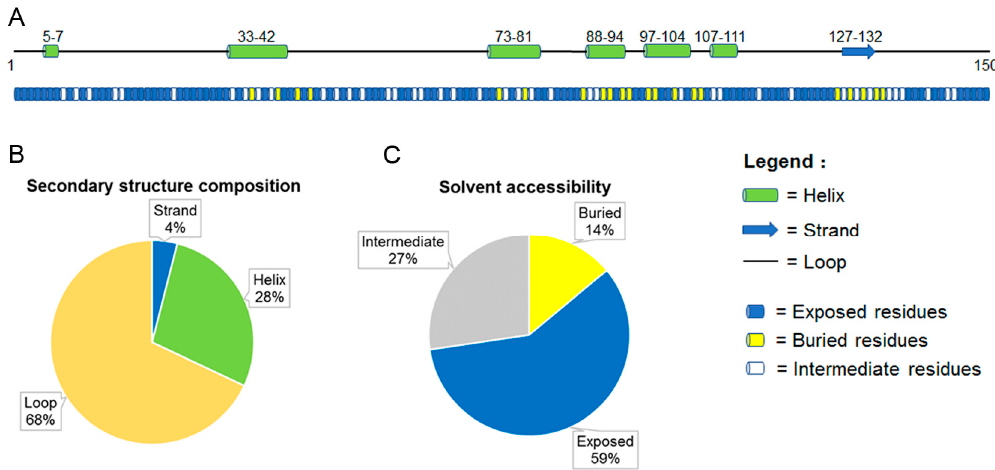
Figure 2. Secondary Structure and Solvent Accessibility Prediction for mouse primordial germ cell 7 (PGC7) (UniProt ID: Q8QZY3). ( A ) The secondary structure and solvent accessibility information generated for mouse PGC7 by PredictProtein server (https://www.predictprotein.org/). The predicted secondary structures are shown in upper part of the figure. Three states of secondary structure are predicted: helix (includes α -, π - and 3_10-helix), strand (extended strand in β -sheet conformation of at least two residues length) and loop. The prediction of solvent accessibility for all residues are shown in the lower part of the figure. The predicted exposed (light blue), intermediate (white) and buried (yellow) residues exposed with more than 36%, 9-36%, and less than 9% of their surface, respectively. ( B ) The secondary structure composition of PGC7. ( C ) The percentage of exposed, intermediate and buried residues in PGC7.